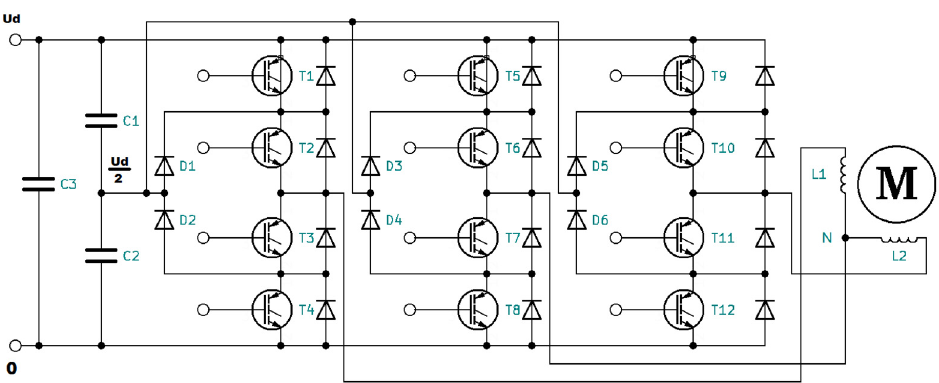
Figure 1. Three-leg three-level NPC inverter used to power a two-phase induction motor. T1–T12 are the IGBT transistors, D1–D6 are the neutral point clamping diodes, C1–C3 are the filtering capacitors, M is the two-phase squirrel cage induction motor, and L1–L2 are its windings. The usability of the method was confirmed by implementation on a prototype 3L-NPC inverter.